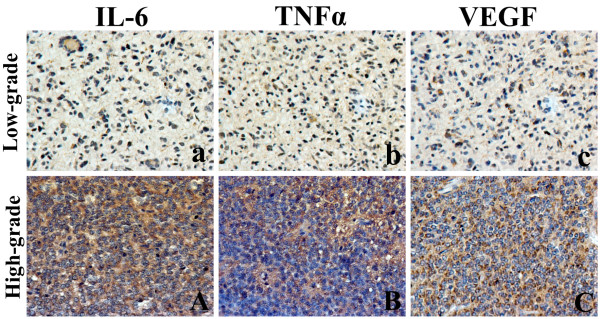
Immunohistochemical staining of IL-6, TNFα and VEGF in low and high grade of glioma tissues. Low-grade gliomas showed low expression of IL-6 (a), TNFα (b) and VEGF (c) positive tumor cells in serial section. High expression of IL-6 (A), TNFα (B) and VEGF (C) was shown in high-grade gliomas. (magnification: ×400).